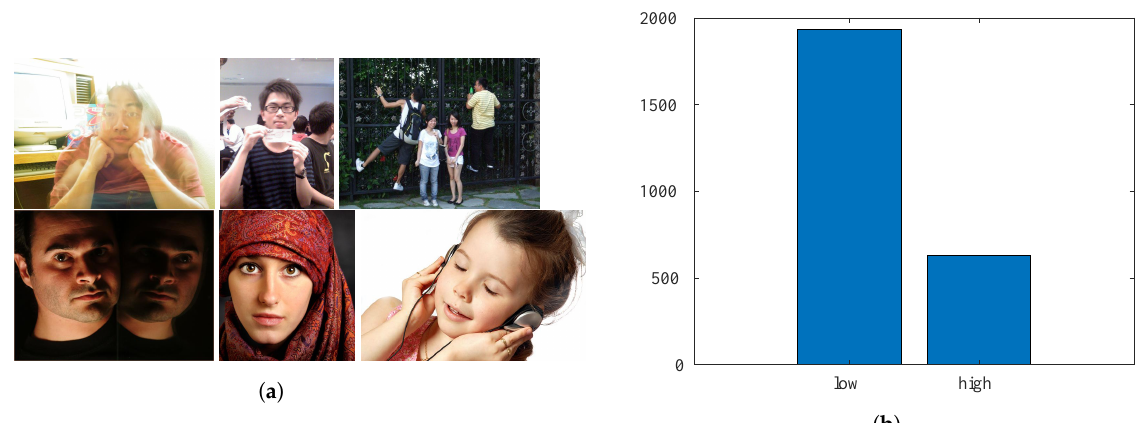
Figure 8. Sample images and number of samples per category for the CUHKPQ database. ( a ) Sample images in the top row were annotated as low aesthetic quality, while samples in the bottom row show high aesthetic quality images. ( b ) Annotation distribution for the low-/high-quality classes.